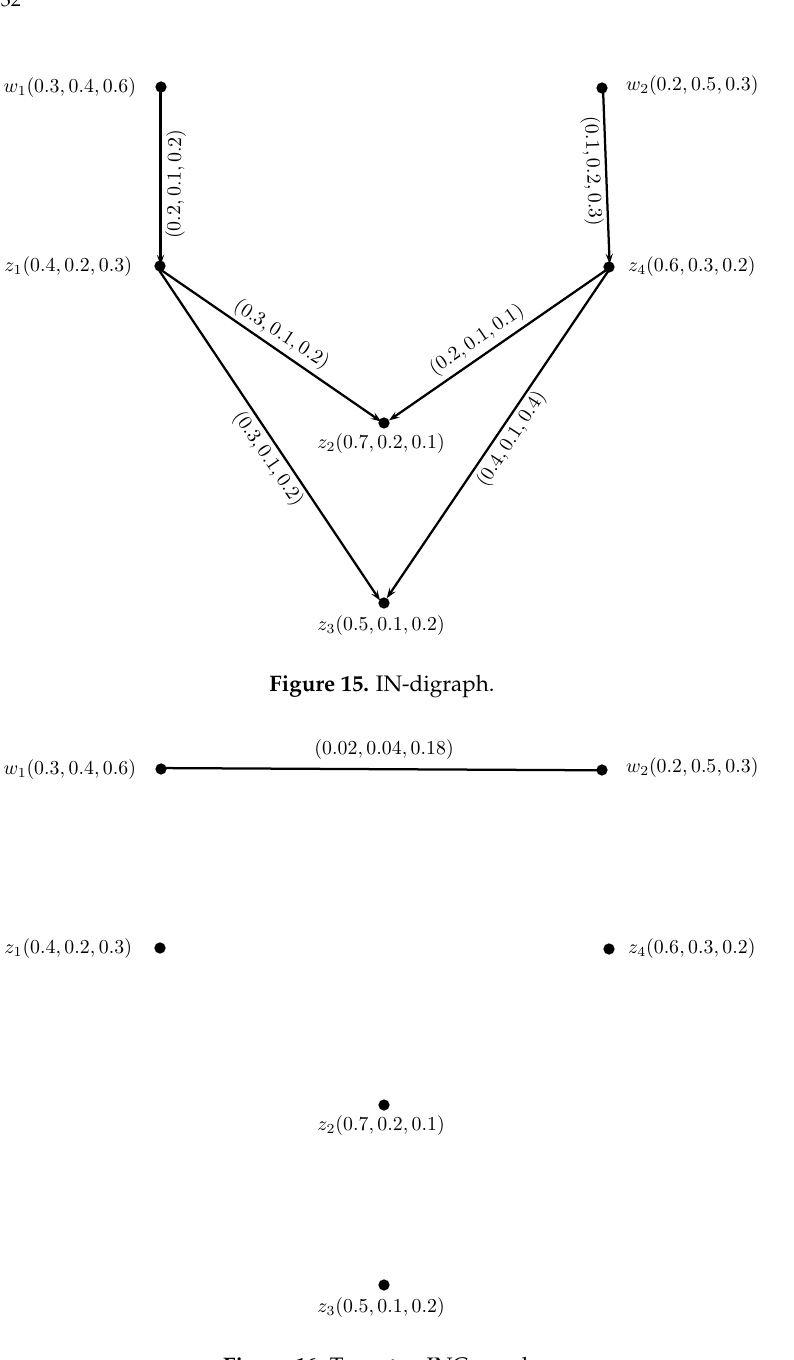
Figure 16. Two-step